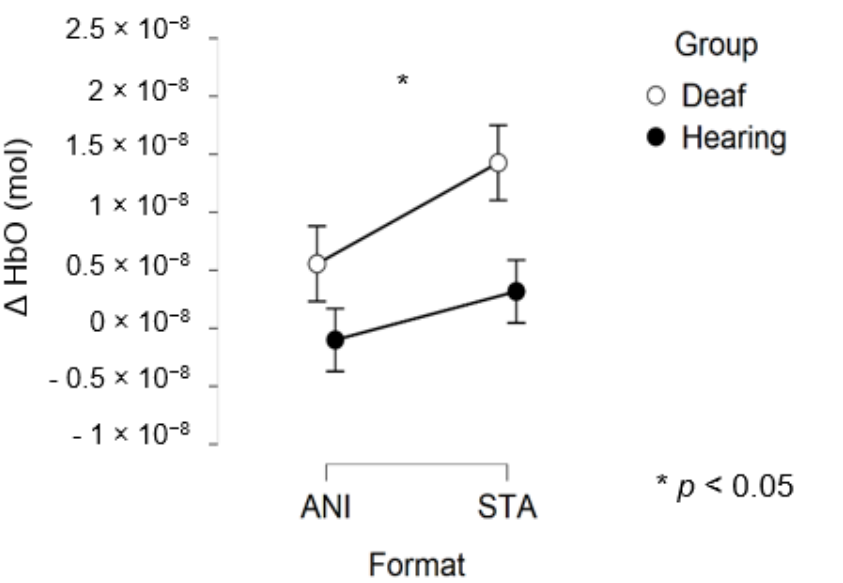
Figure 8. Mean amplitude values of the hemodynamic evoked responses in the central region for animated (ANI) and static image sequence (STA) formats for both groups.